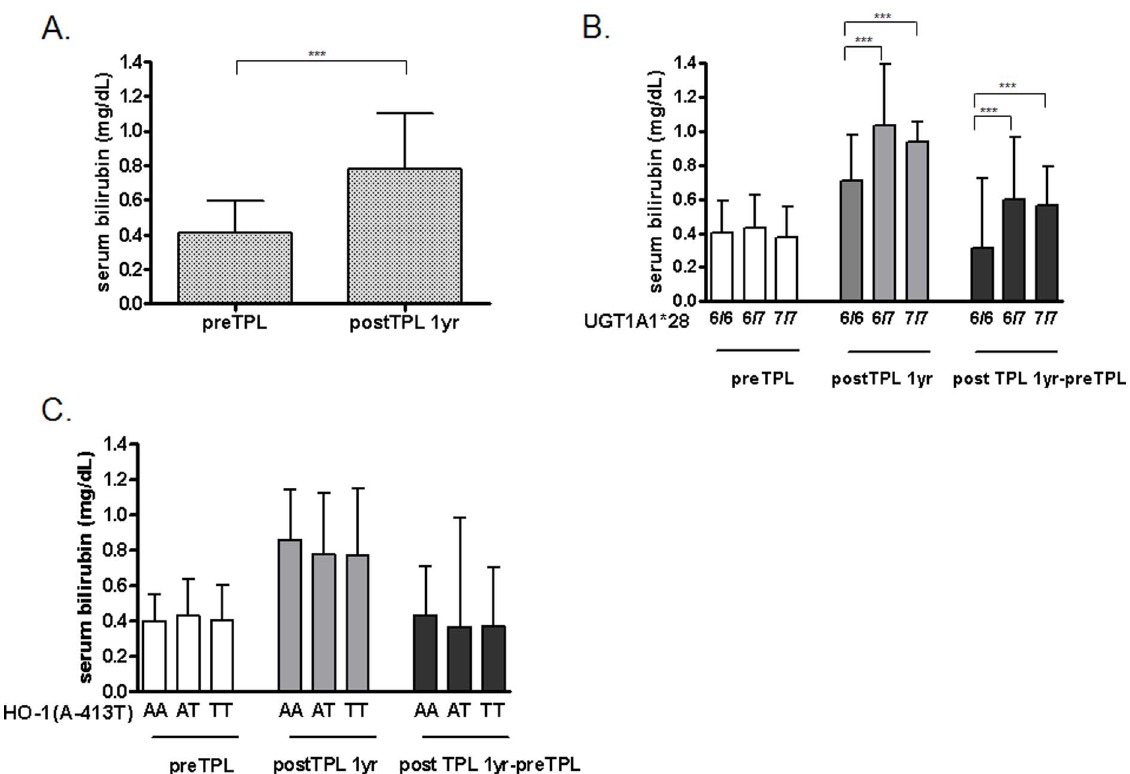
Figure 1. Changes in serum bilirubin levels after kidney transplantation according to sequence variation. (A) Pre- and post-transplant serum bilirubin levels. (B) Serum bilirubin level according to UGT1A1*28 polymorphism. (C) Serum bilirubin level according to HO-1 (A-413T) polymorphism. Mean 6 SD. *** P , 0.001.